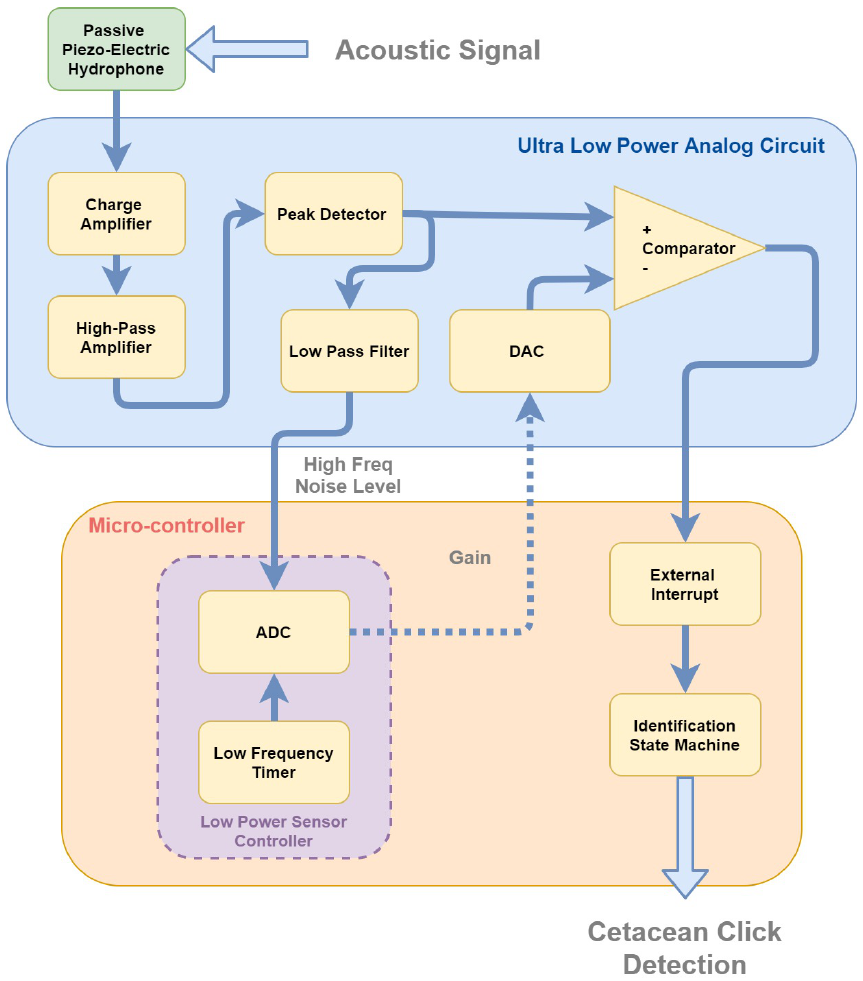
Figure 7. Sperm Whales detector block